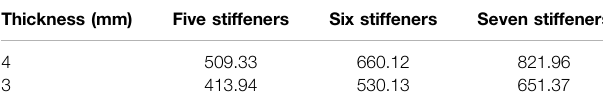
TABLE 10 | The fi rst-order natural frequency of each model